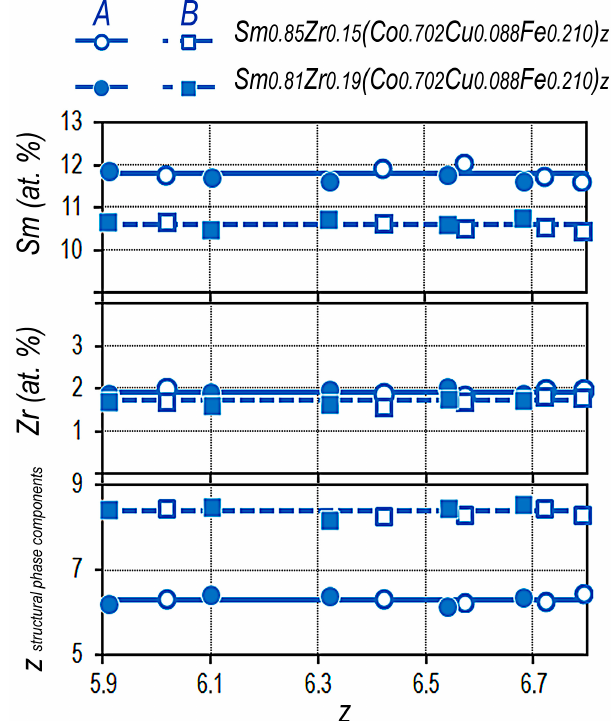
Figure 5. Dependencies of Sm and Zr concentrations and the ratio of (3 d ) / (4 f ,4 d ) elements of main structural components z A and z B on the integral z of the Sm 1-X Zr X (Co 0.702 Cu 0.088 Fe 0.210 )z alloys with x = 0.15 and 0.19.